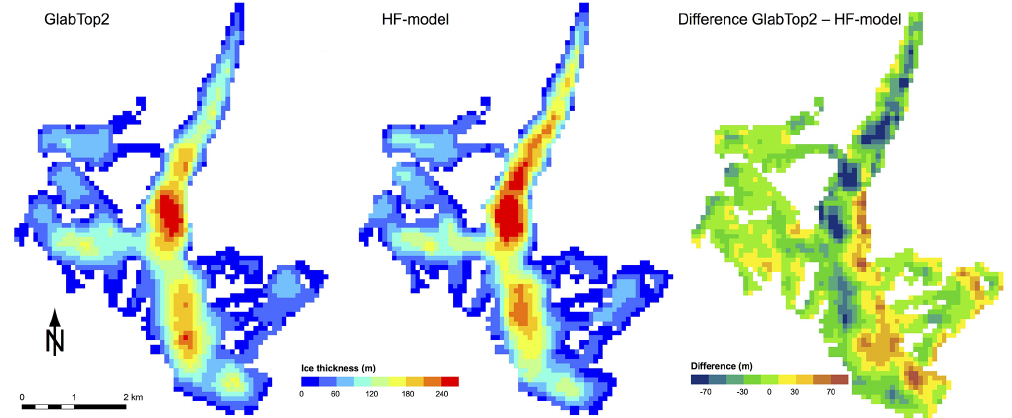
Figure 6. Ice-thickness distribution of Chhota Shigri (W – Himalayas) modeled with GlabTop2 (left panel) and the HF-method (middle panel). Corresponding ice-thickness differences are shown on the right panel.